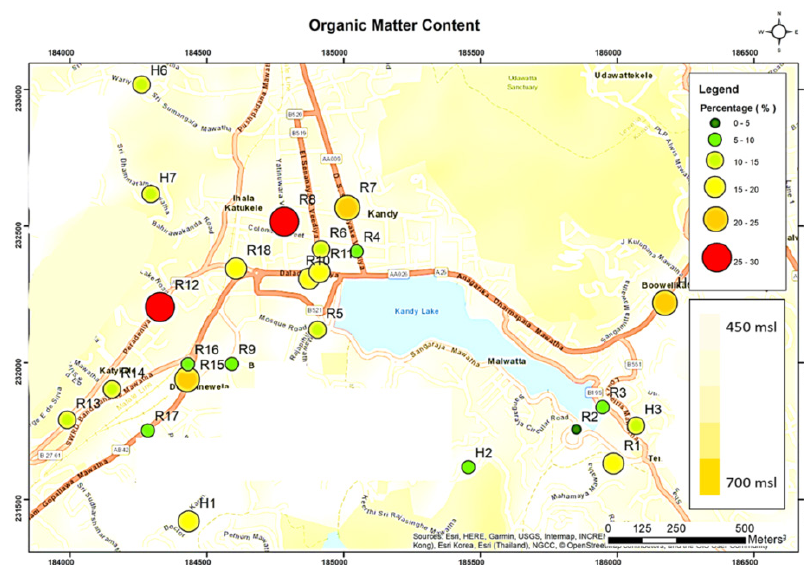
Figure 1: Map showing the distribution of organic materials in the study area.